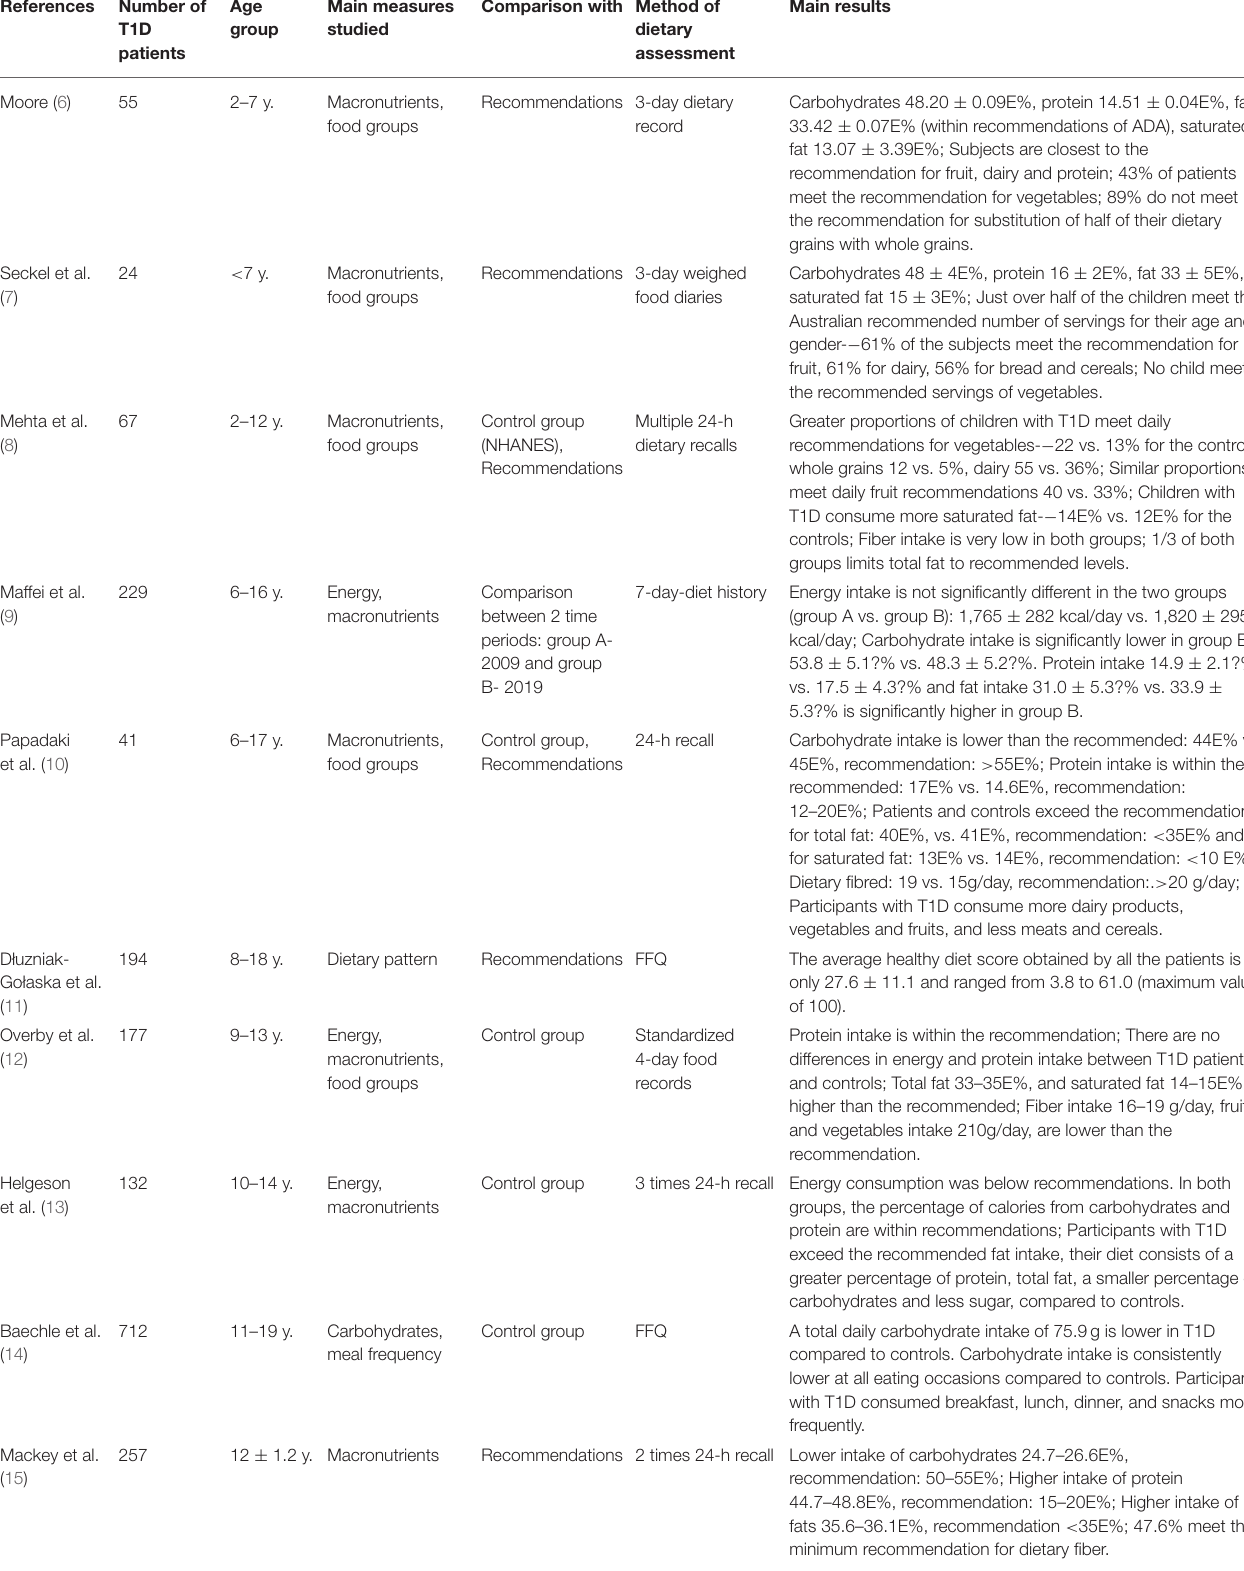
TABLE 1 | Main measures and nutrition outcomes among T1D